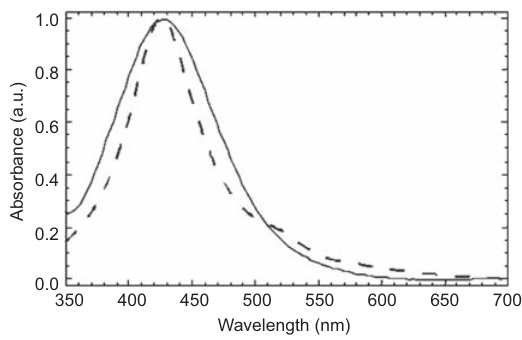
Figure 5 Comparison of normalized theoretical (dashed line) and experimental (solid line) extinction spectrum of silver nanoparticles embedded in polystyrene fi